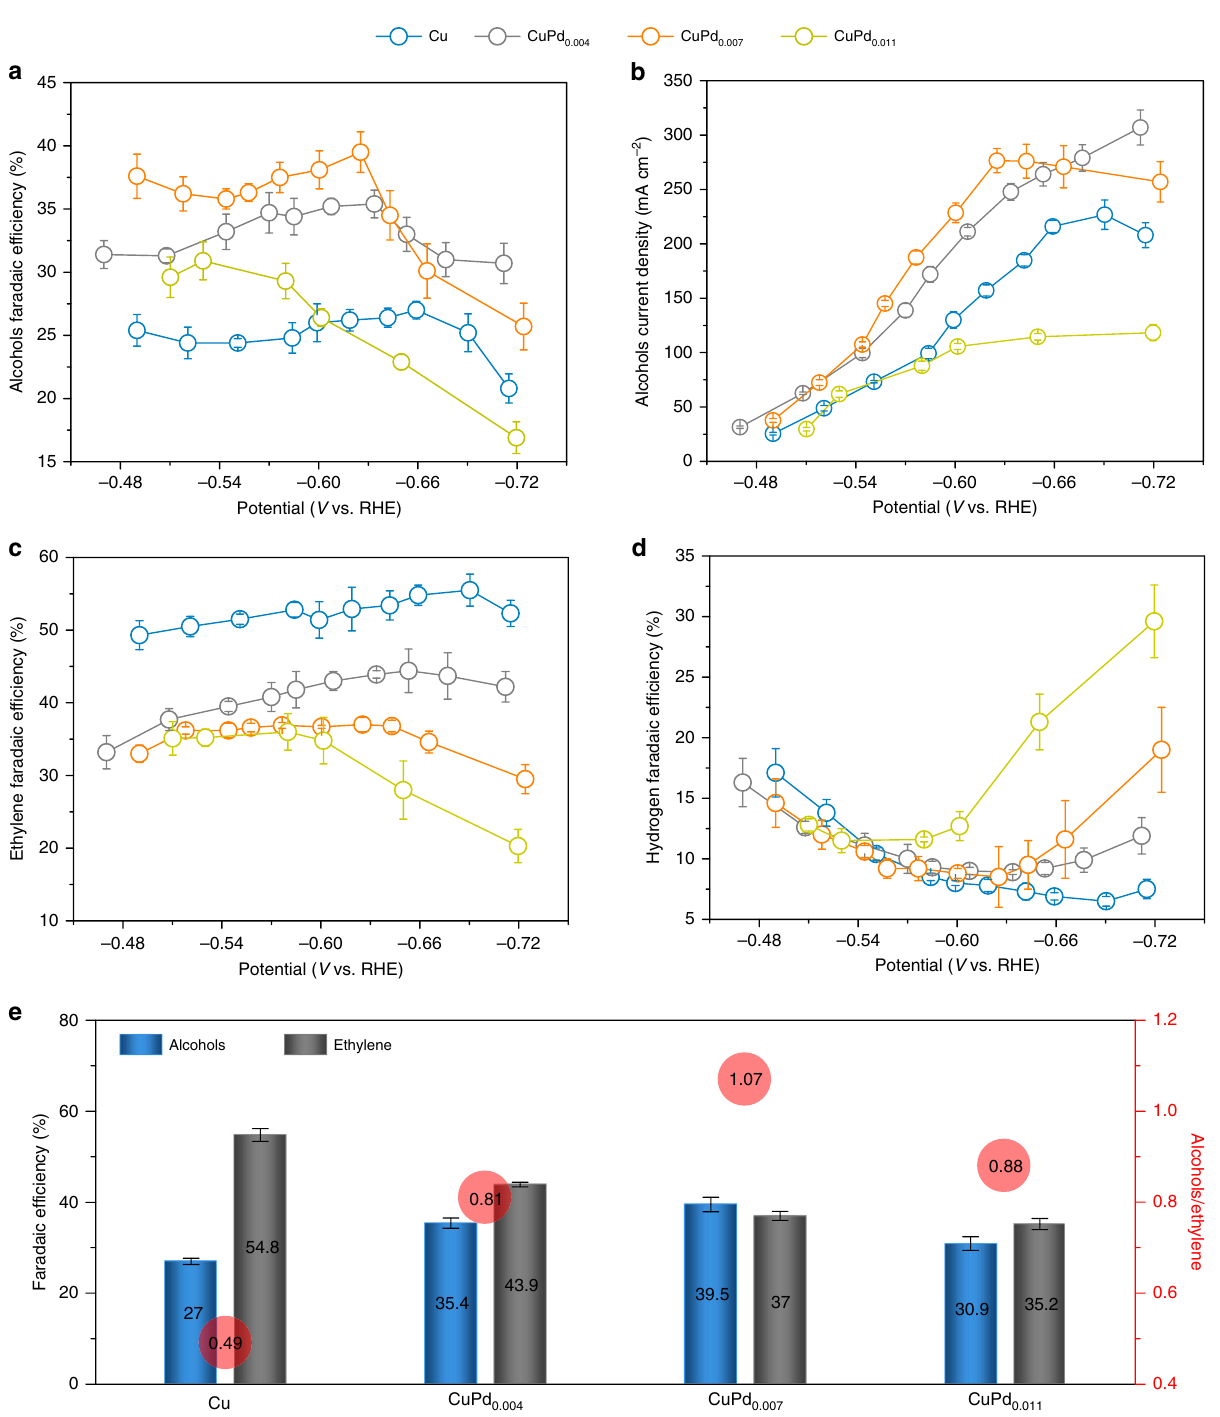
Fig. 4 COR performance of Pd-doped Cu electrocatalysts. a – d COR product selectivities (FE, %) and activities (partial current densities, mA cm − 2 ) towards alcohols ( a , b ), ethylene ( c ) and hydrogen ( d ) productions on Cu, CuPd 0.004 , CuPd 0.007 and CuPd 0.011 catalysts at various applied potentials (vs. RHE) in 1 M KOH. e The peak alcohol selectivities and relevant ethylene selectivities on different catalysts at − 0.66 V (Cu), − 0.63 V (CuPd 0.004 ), − 0.62 V (CuPd 0.007 ) and − 0.53 V (CuPd 0.011 ) vs. RHE. Numbers in the red circles show the corresponding Faradaic ef fi ciency ratio of alcohol to ethylene. Error bars are means± SD ( n = 3 Methods to the orbital occupation was applied during the geometry optimization and for the DFT calculations . We performed density functional theory calculations with the total energy computations. In all calculations, the atoms at all positions have Hellmann – Feynman forces <0.02 eVA ̊ − 1 and the electronic iterations convergence Vienna Ab Initio Simulation Package (VASP) code 36,37 . The exchange correlation was 10 − 5 eV using the Normal algorithm. A 6-layer (4 × 4) Cu (111) supercell was energy was modelled by using Perdew-Burke-Ernzerhof (PBE) functional within built to simulate the exposed surface of copper accompanying with a suf fi cient the generalized gradient approximation (GGA) 38 . The projector augmented wave vacuum gap of 15 Å. Heteroatoms were exposed on the surface by replacing a Cu (PAW) pseudo-potentials 39 were used to describe ionic cores. The cut-off energy of atom. Structural optimizations were performed on all modi fi ed slab models with a 450 eV was adopted after a series of tests. A Methfessel-Paxton smearing of 0.05eV